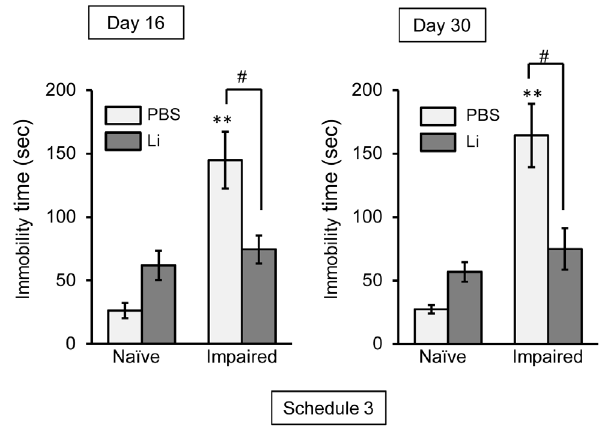
Figure 8. Lithium (Li) ameliorates TMT-induced depression-like behavior. Animals were given either lithium carbonate (100 mg/kg, i.p.) or PBS daily on days 2 to 15 post-treatment with TMT or PBS prior to the forced swimming test, which was conducted on days 16 and 30 post-TMT treatment (Schedule 3). Values are expressed as the mean 6 S.E. calculated from 4–6 animals. ** P , 0.01, significantly different from the control value obtained for the naı¨ve group. # P , 0.05, significant difference between the values obtained for PBS and Li groups.